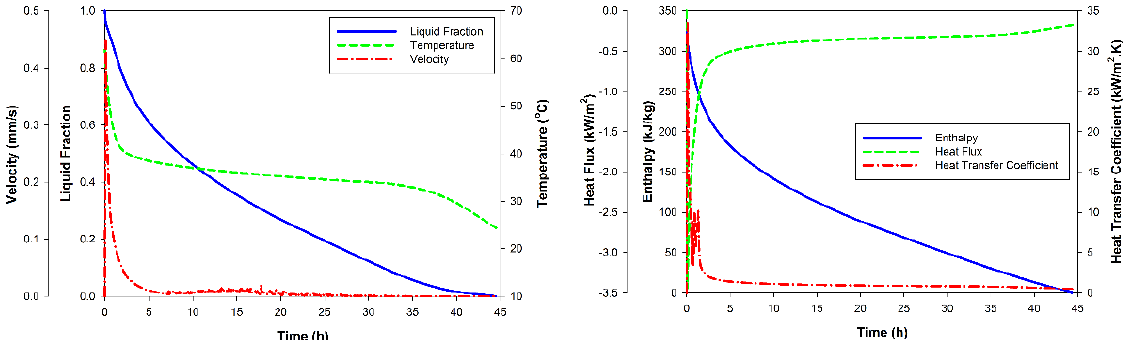
Figure 3. Transient performance of paraffin throughout the discharging cycle in the shell-and-tube with no-fins configuration (case 1).